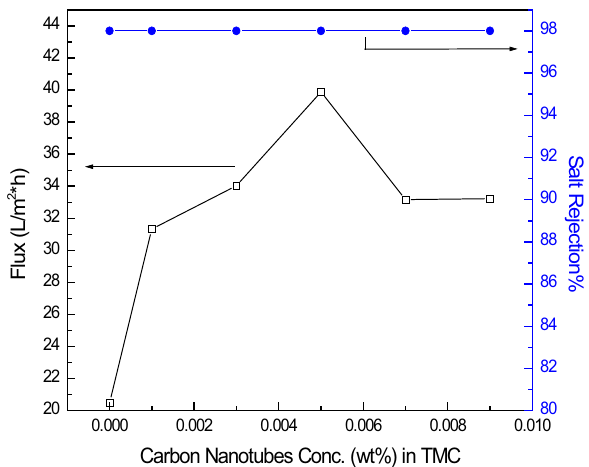
Fig. 11 Permeate flux and salt rejection of pristine-MWCNT in TMC solution